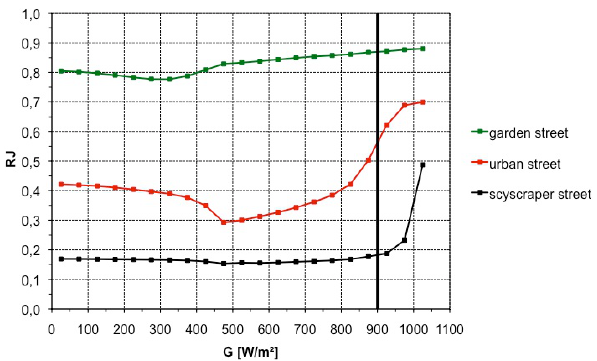
Fig. 9. Ratio RJ of NO 2 photolysis frequency in a street canyon and for undisturbed conditions as function of the solar global irradiance G for three street types. The values are averaged over the street ori- entation and the meteorological conditions (see text). The vertical line at 900W/m 2 cuts out conditions with global solar irradiance that, in general, do not occur for mid